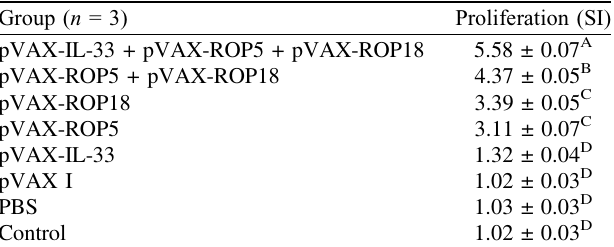
Table 2. Proliferative response of lymphocytes of immunized Kunming mice after stimulation by Toxoplasma gondii lysate